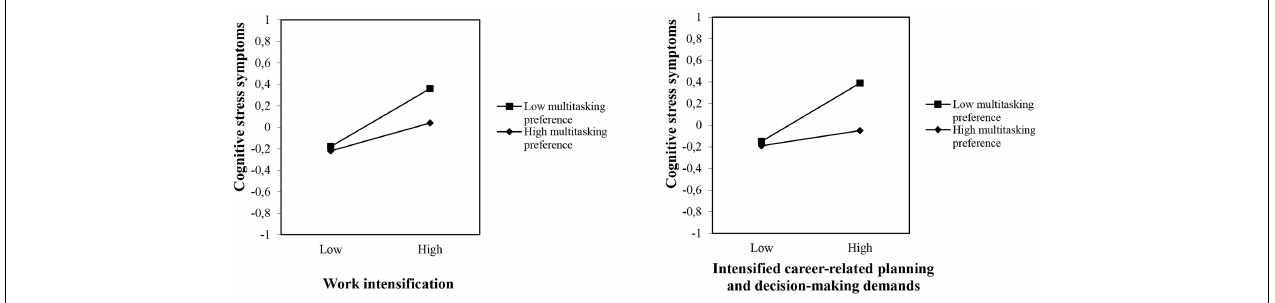
FIGURE 2 | Multitasking preference as a moderator in the association between work intensification/intensified career-related planning and decision-making demands and cognitive stress symptoms. The scale on the Y -axis as well as the entries “low” and “high” refer to –1 and +1 standard deviation below and above the sample mean in the variable in